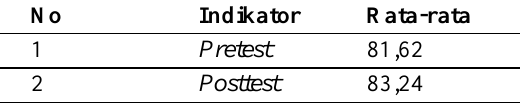
Tabel 4. Hasil Rata-Rata Pretest dan